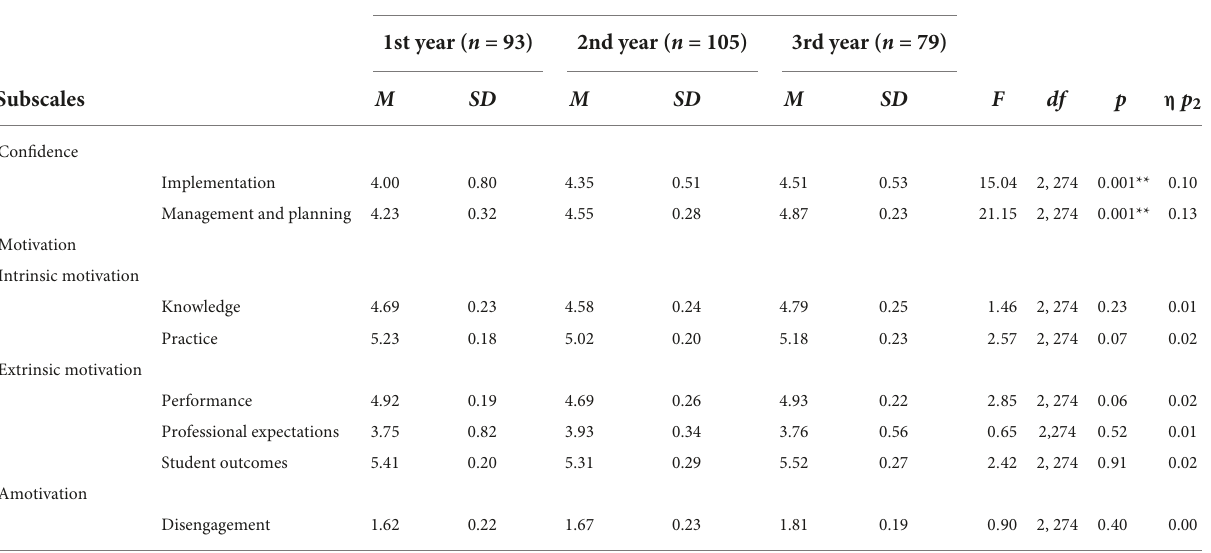
TABLE 5 Descriptive statistics and ANOVA results confidence and motivation by year